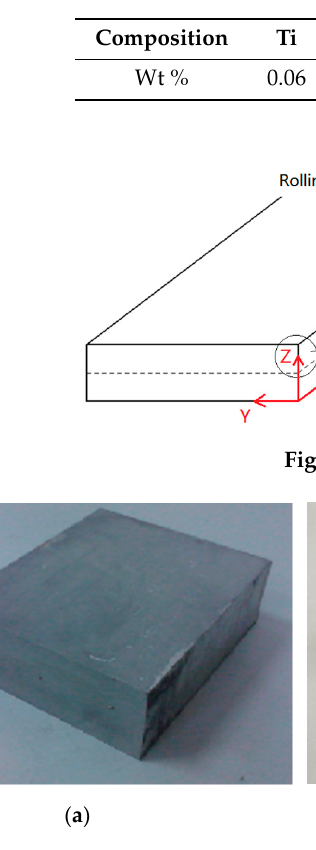
Figure 3. Specimen preparation process. ( a ) 7050-T7451 aluminum alloy plate; ( b ) aluminum alloy cylinder; ( c ) compression specimen.